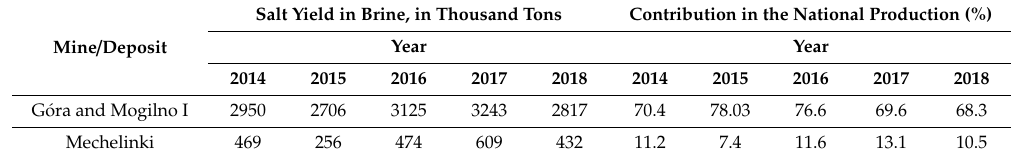
Table 1. Salt production in brine in Poland [23].